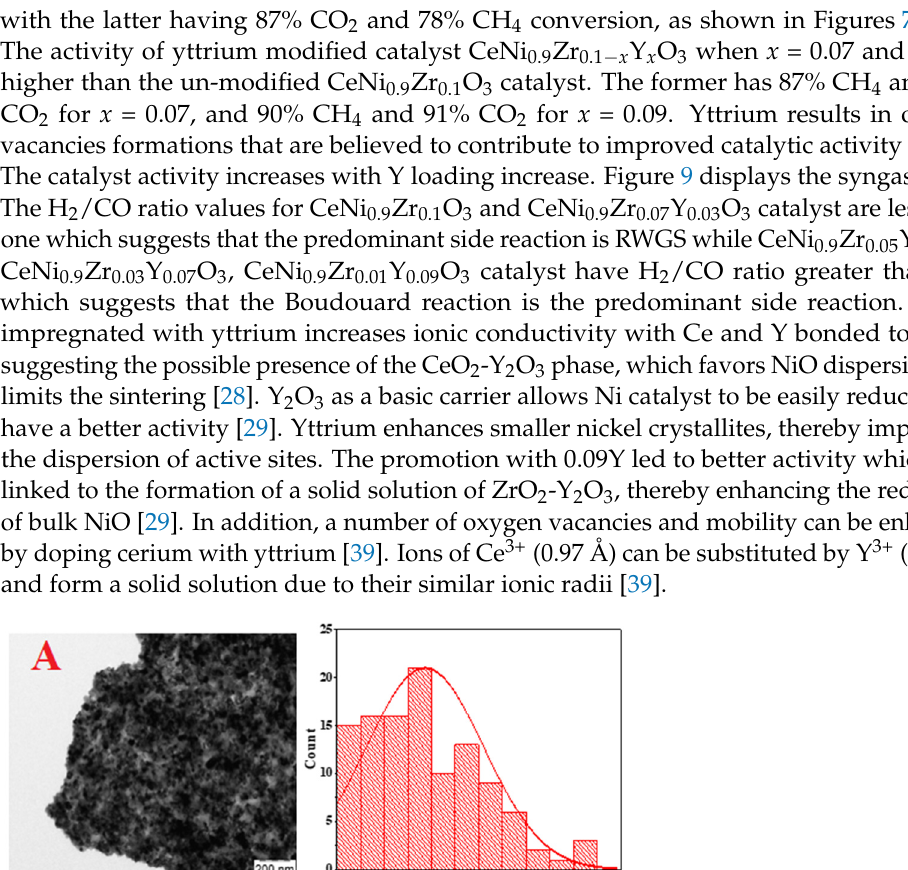
Figure 6. TEM micrographs and matching particle size distribution for fresh CeNi 0.9 Zr 0.01 Y 0.09 O 3. ( A ) and used CeNi 0.9 Zr 0.01 Y 0.09 O 3. ( B ) catalyst.